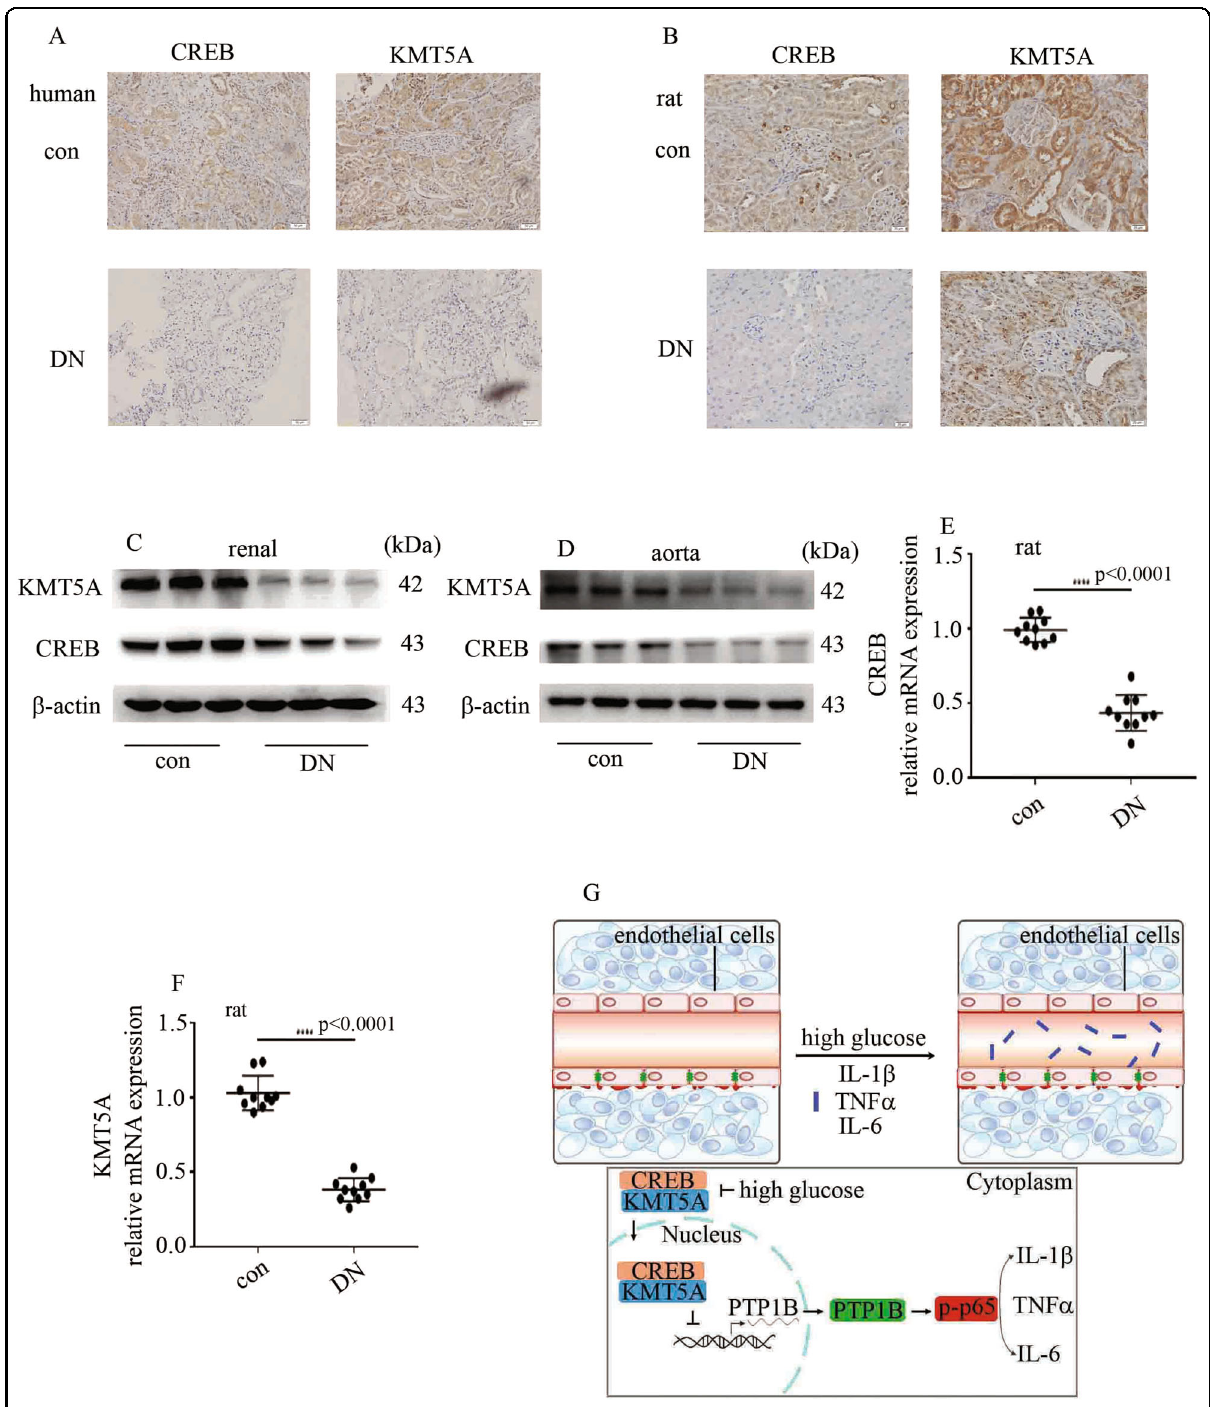
Fig. 7 Veri fi cation of high glucose-mediated decreases in KMT5A and CREB in DN patients and rats. A Immunostaining of CREB and KMT5A in renal biopsy specimens of DN patients and control participants ( n = 20/group). B Immunostaining of CREB and KMT5A in renal biopsy specimens of DN rats and control rats ( n = 10/group). C Protein expression of CREB and KMT5A in the renal tissues of control rats and DN rats was assessed by western blot. D Protein expression of CREB and KMT5A in the aorta tissues of control rats and DN rats was assessed by western blot. E , F mRNA expression of CREB and KMT5A in aorta tissues of DN rats and control rats was assessed by qPCR ( n = 10/group). G Schematic representation of the working model. (* p < 0.05, ** p < 0.01, *** p < 0.001, **** p < 0.0001, n =